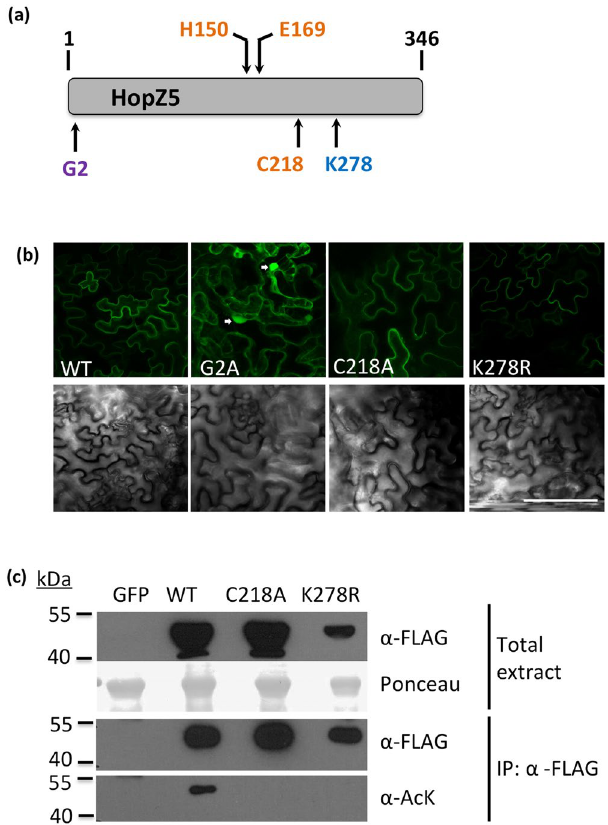
Figure 3. Plasma membrane localization and autoacetylation are affected in HopZ5 variants. ( a ) Key residues for HopZ5 function predicted through conservation between YopJ family members. Line model for HopZ5 peptide with putative myristoylation residue (glycine, G2), acetyltransferase catalytic core residues (histidine, H150; glutamate, E169; cysteine, C218) and autoacetylation-required site (lysine, K278) is shown. Mutants generated in this study include a glycine to alanine mutation (G2A), cysteine to alanine (C218A) and a lysine to arginine (K278R). ( b ) In planta subcellular localization of HopZ5 variants was determined in SGT1 -silenced N . benthamiana . Leaves were infiltrated with Agrobacterium tumefaciens AGL1 carrying YFP-tagged hopZ5 (WT), hopZ5 (G2A), hopZ5 (C218A) or hopZ5 (K278R) under a constitutive CaMV 35 S promoter. Leaf discs were taken at 2 days post infiltration and visualized under confocal laser-scanning microscopy for localization of the YFP tag. Top and bottom panels are confocal images and corresponding bright-field images, respectively. White arrows in G2A sample indicate plant cell nuclei. Scale bar represents 50 μ m. ( c ) Detection of acetylated wild- type HopZ5 (WT), but not HopZ5-C218A and HopZ5-K278R from transient expression in N . benthamiana SGT1 -silenced plants. Protein was extracted from leaf samples 2 days post infiltration. Protein presence in total extract was tested by α -FLAG antibody and acetylation status tested by immunoblot with an α -AcK antibody after α - FLAG immunoprecipitation. Ponceau Red staining of total protein extract shows sample